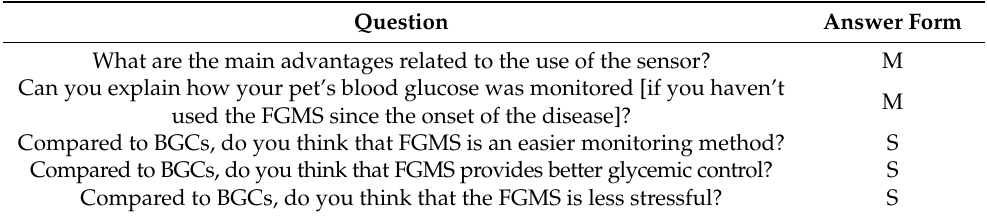
Table 2. Questions related to the comparison between the use of flash glucose monitoring system (FGMS) and the generation of blood glucose curves (BGCs).